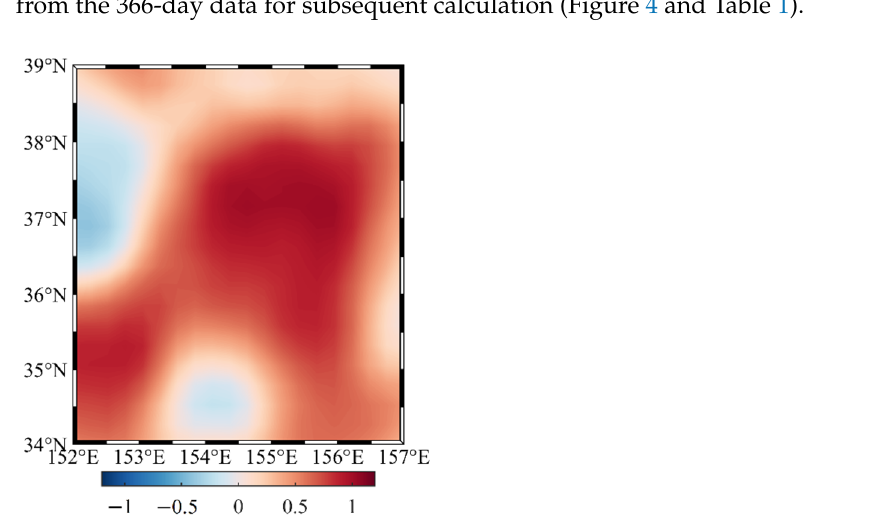
Figure 3. Annual range of global sea level anomalies in 2020 (unit: m).